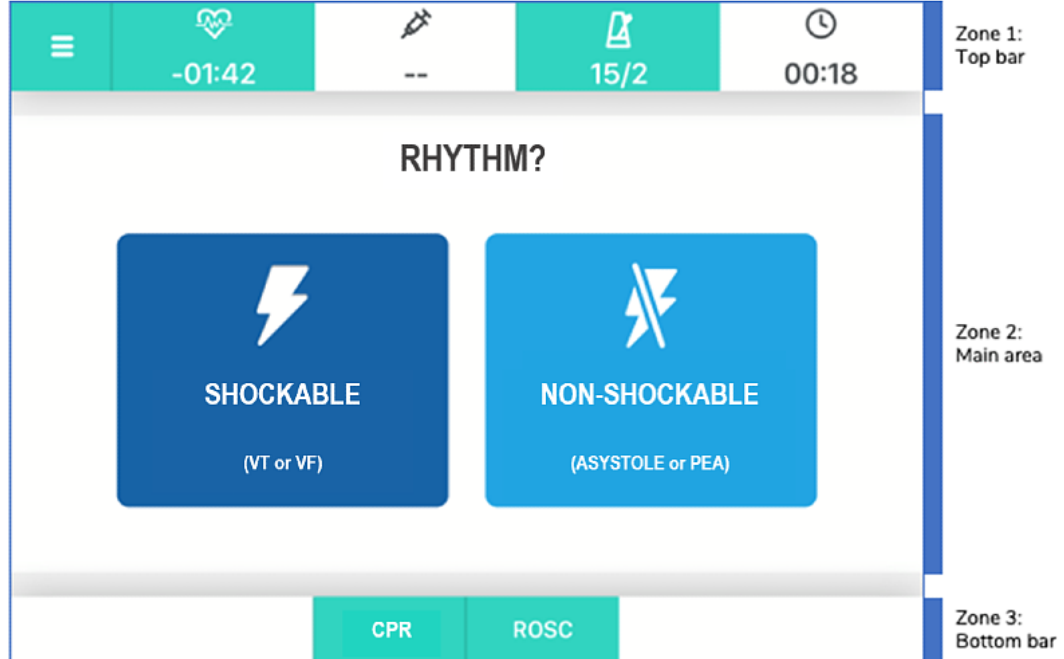
Figure 2. User interface main areas. CPR: cardiopulmonary resuscitation; ROSC: return of spontaneous circulation; VF: ventricular fibrillation; VT: ventricular